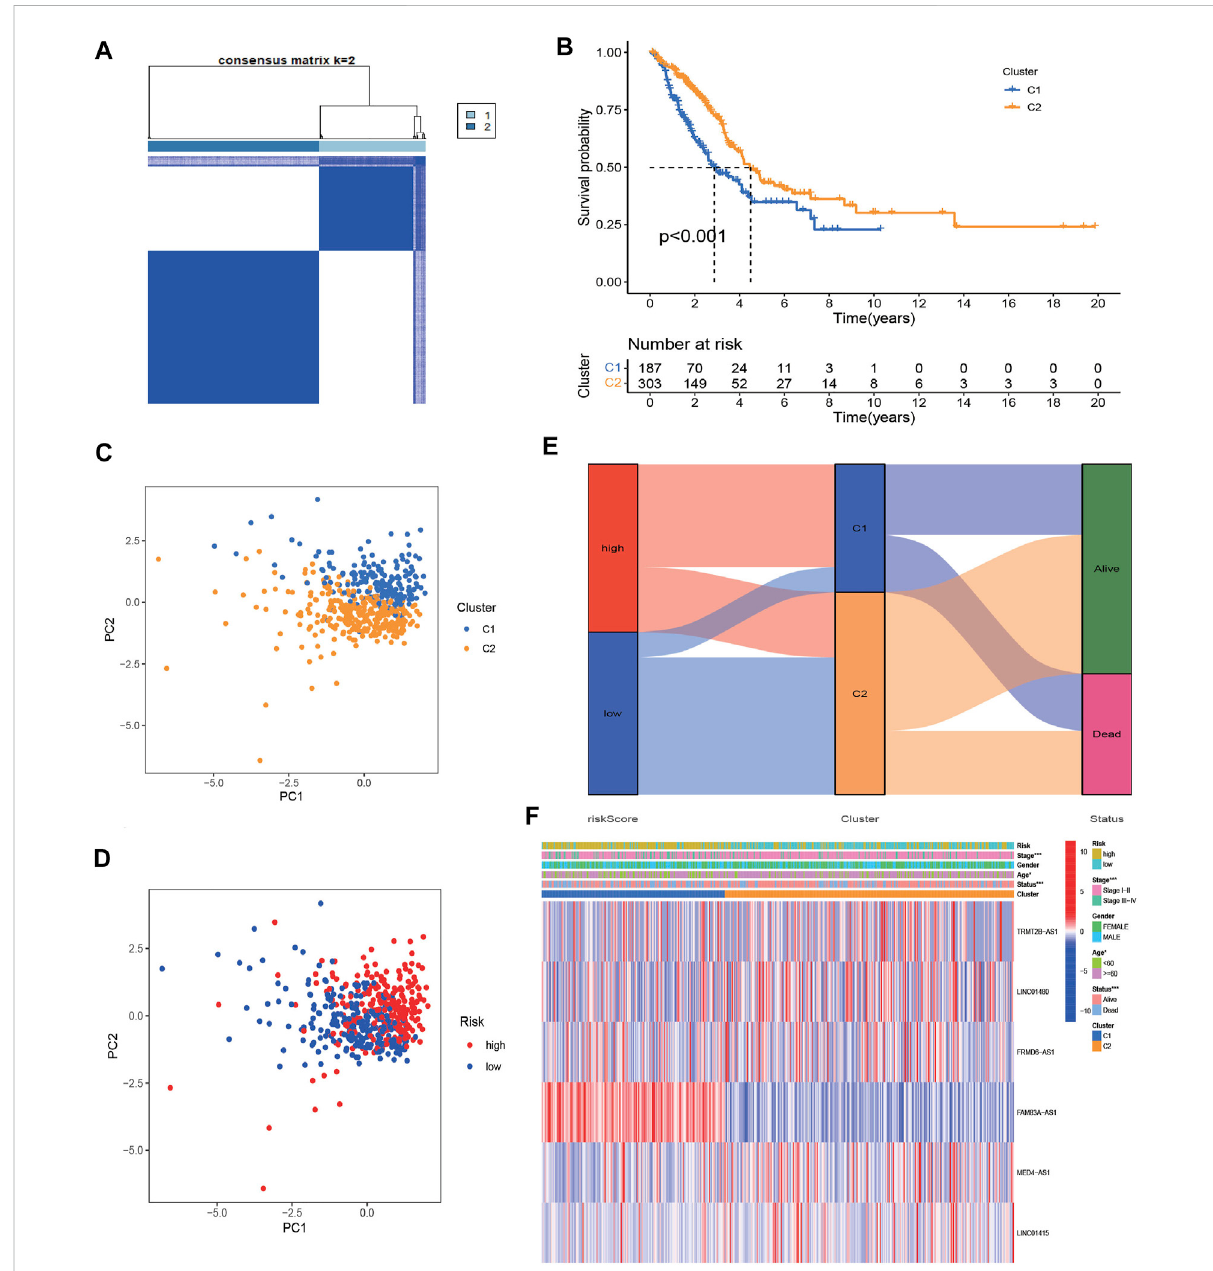
FIGURE 10 Identi fi cation of two clusters based on prognostic NRlncRNAs signature. (A) Consensus clustering (K-means) algorithm was performed for overall patients. Consensus matrix plots. K = 2 was determined as optimal clustering number. (B) K – M survival analysis in clusters C1 and C2. (C,D) The distribution of different patients from two clusters and risk groups. (E) . The Sankey diagram showed distribution of patients in different risk groups, two clusters and survival status. (F) . Heatmap of the lncRNA expression of prognostic NRlncRNAs signature between two